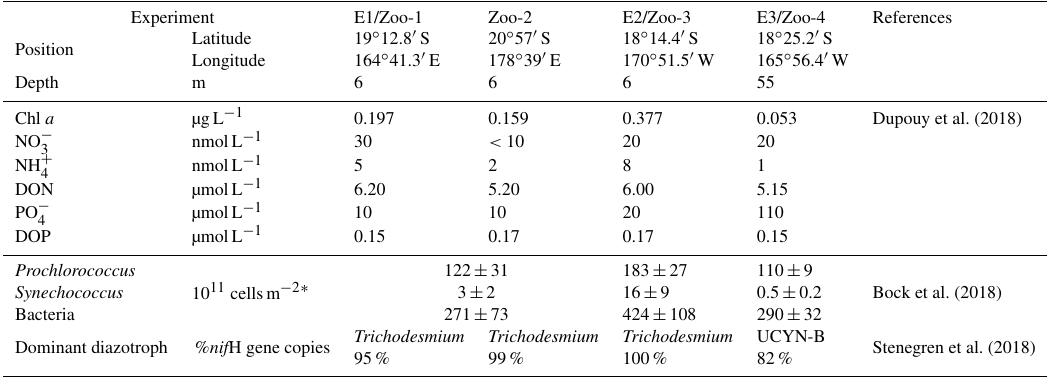
Table 1. Environmental conditions at stations where experiments were performed. Station position, depth of sampling, concentrations of Chl a , NO − , NH + , DON, PO − , DOP, dominant phytoplankton communities and dominant diazotrophs. 3 4 4